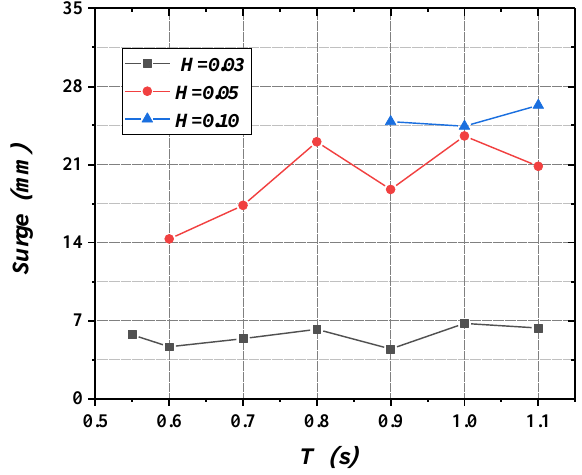
Figure 24. Variations of surge with period and wave height.